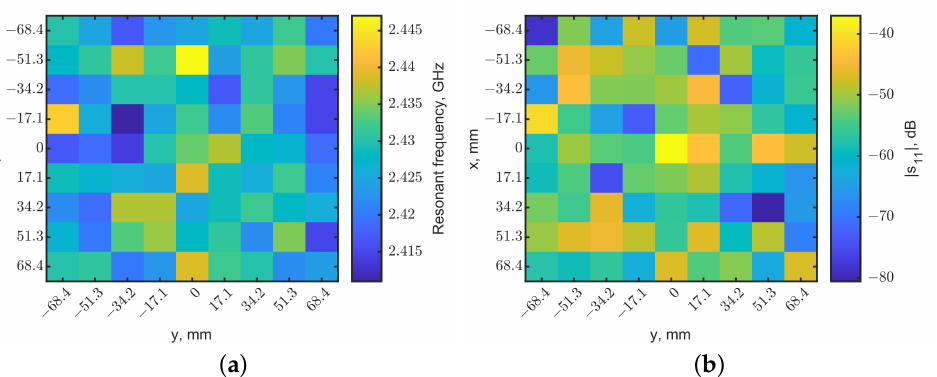
Figure 22. Heatmaps generated from reflection coefficients for a tumor at a depth = 15 mm. The tumor was located at (x = 0, y = 0). ( a ) Map of resonant frequencies and ( b ) map of the magnitudes of reflection coefficients.